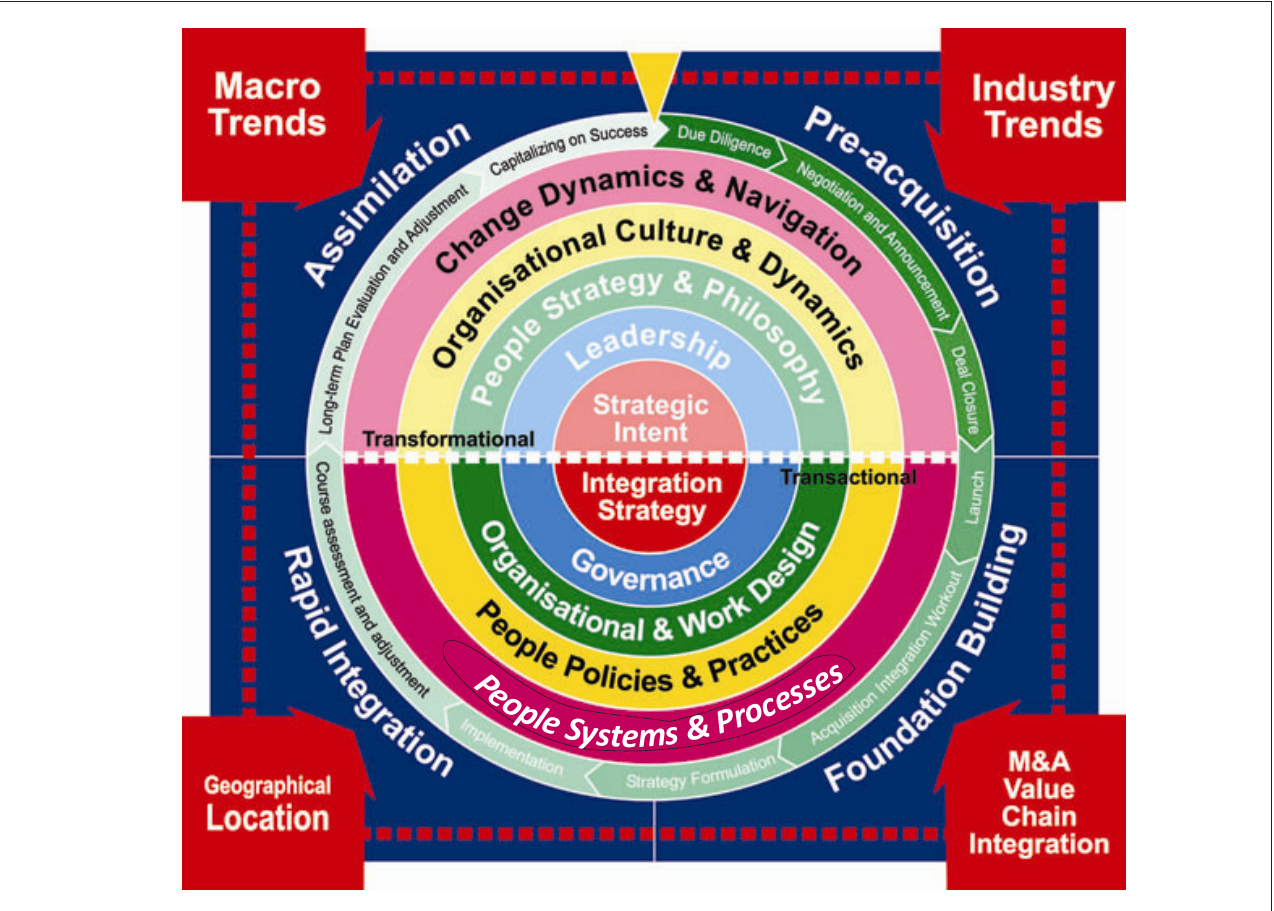
FIGURE 2: A comprehensive, holistic people integration process model (Model